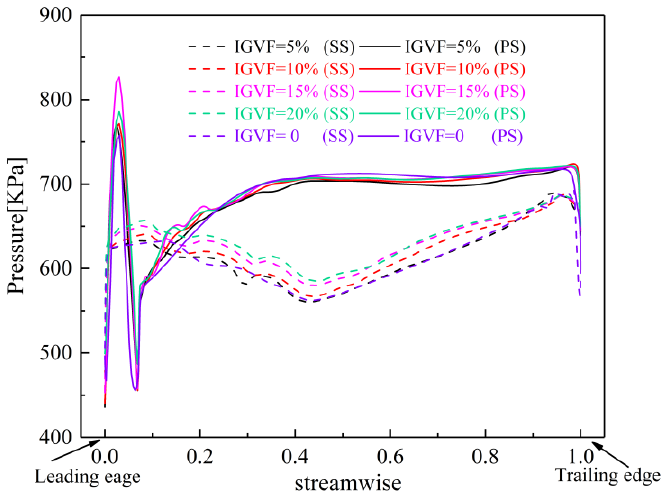
Figure 18. Pressure load near the tip on the